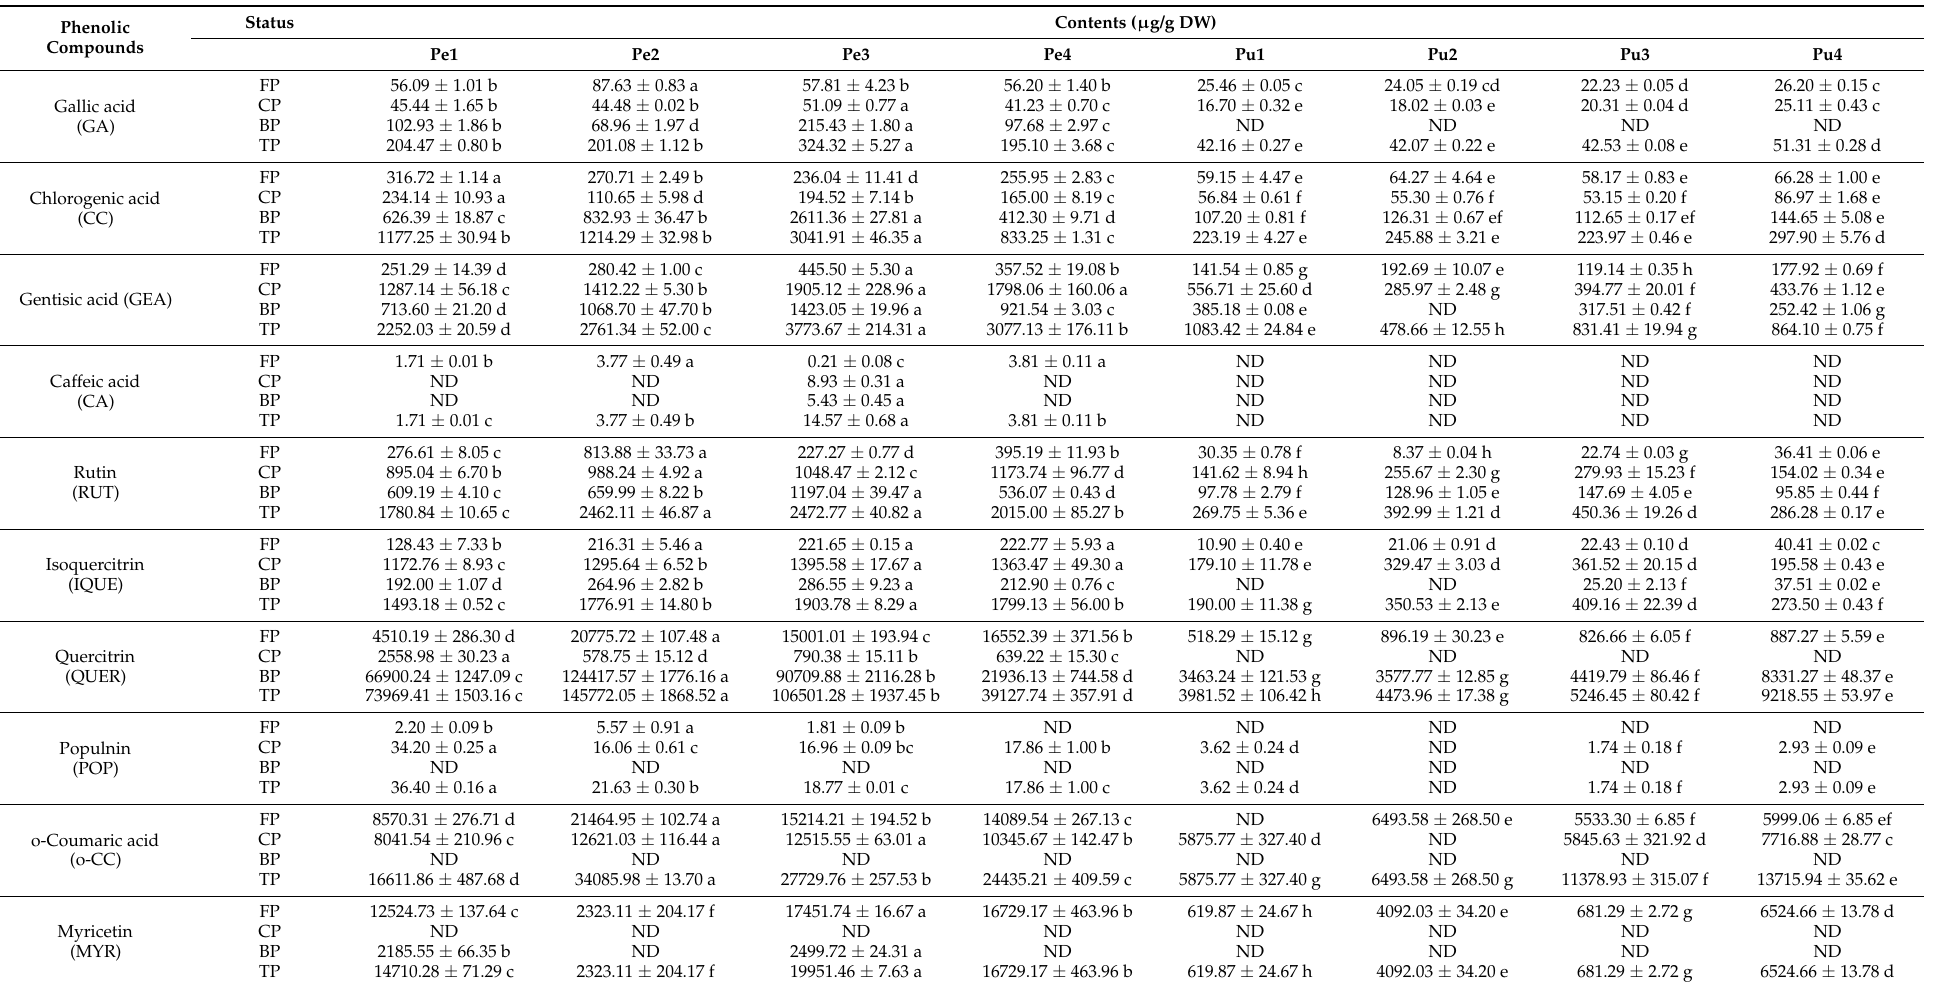
Table 3. Phenolic composition in free, conjugated, and bound fractions of peel and pulp of the four wampee samples from South China ( n =